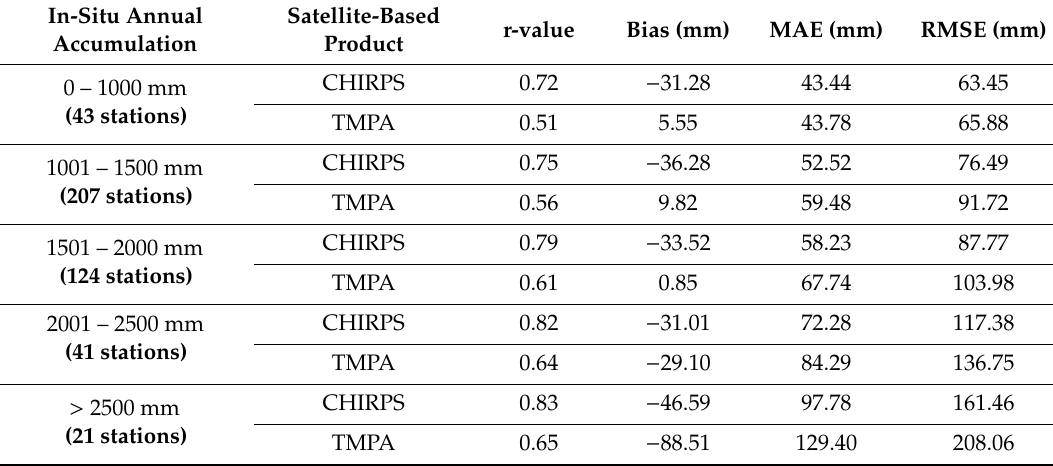
Table 2. Comparison statistic results between rain gauge measurements and satellite-based precipitation estimates for monthly rainfall classes based on in situ accumulation from 2000 to 2014 for R, bias, mean absolute error (MAE), and